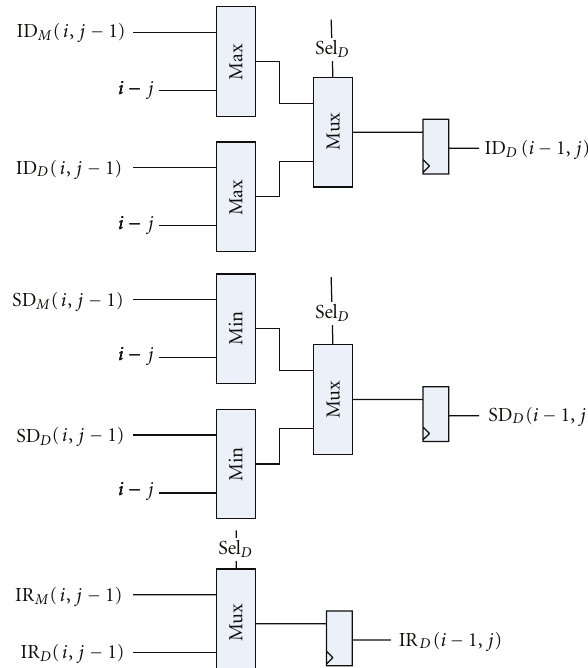
Figure 11: D state divergence calculating stage.